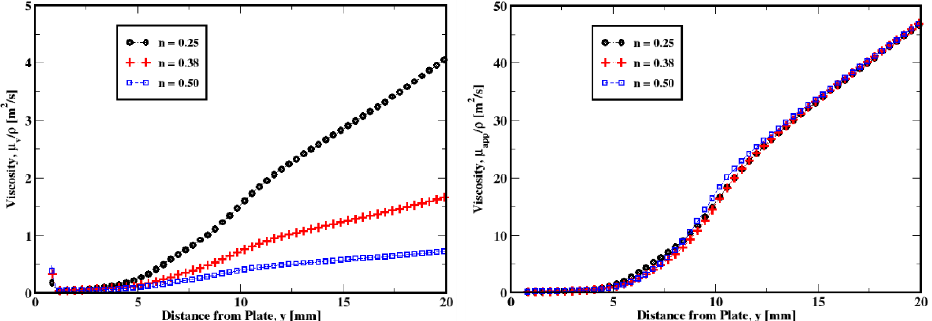
Figure 13. Influence of the power-law exponent on the viscous ( left plot) and the apparent ( right plot) viscosities for the plate immersion velocity of 1 mm/s.